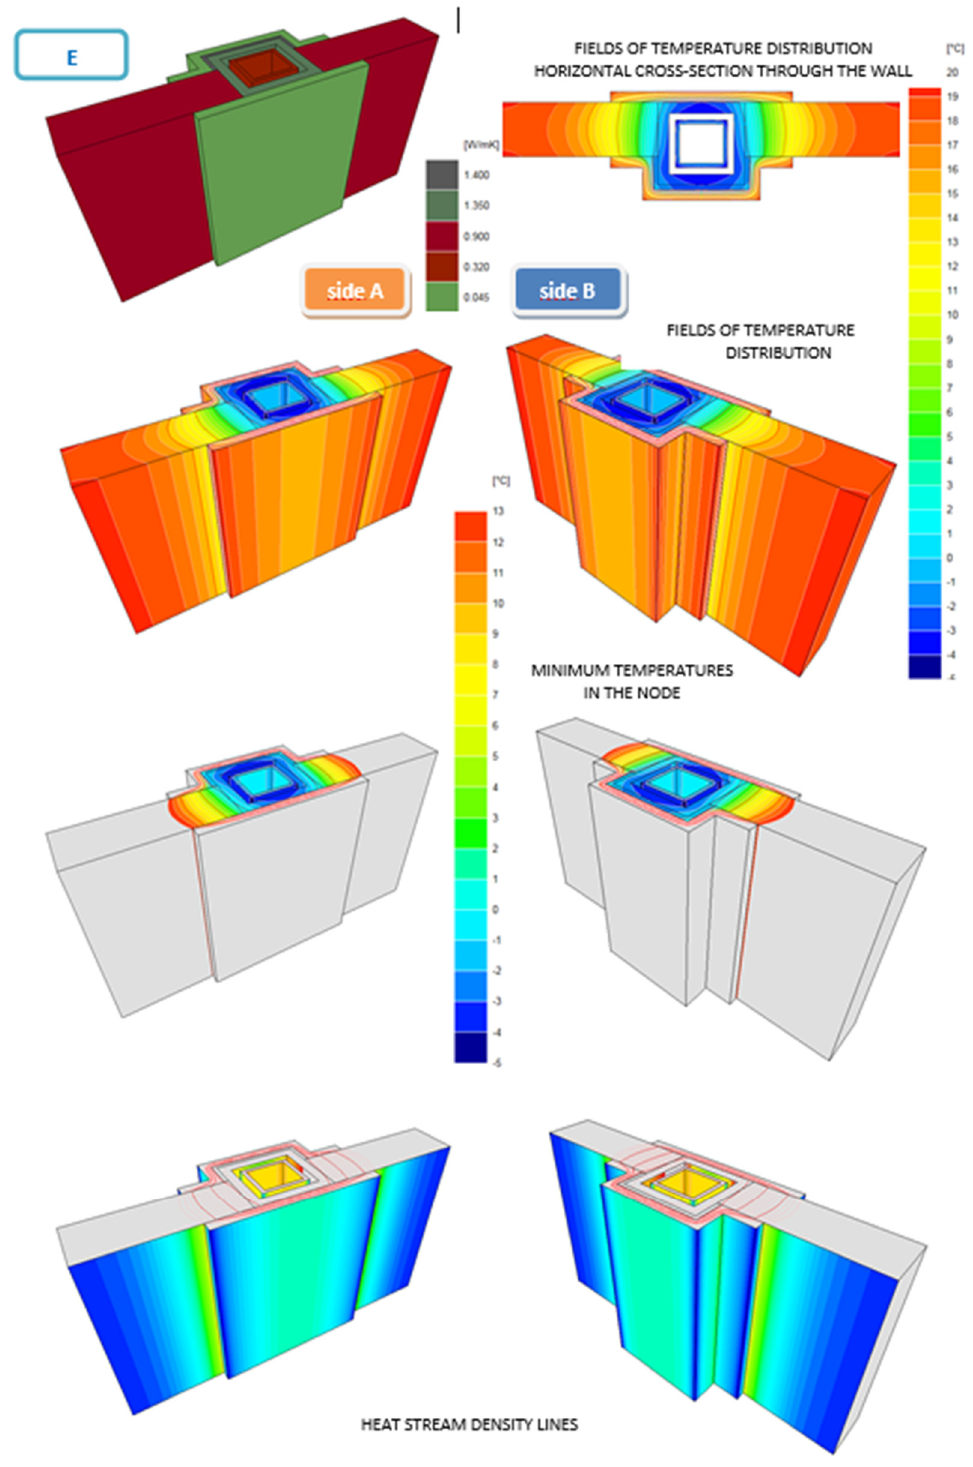
Figure A5. Scheme E: distribution of isotherms, minimum surface temperature, and heat flux distribution.